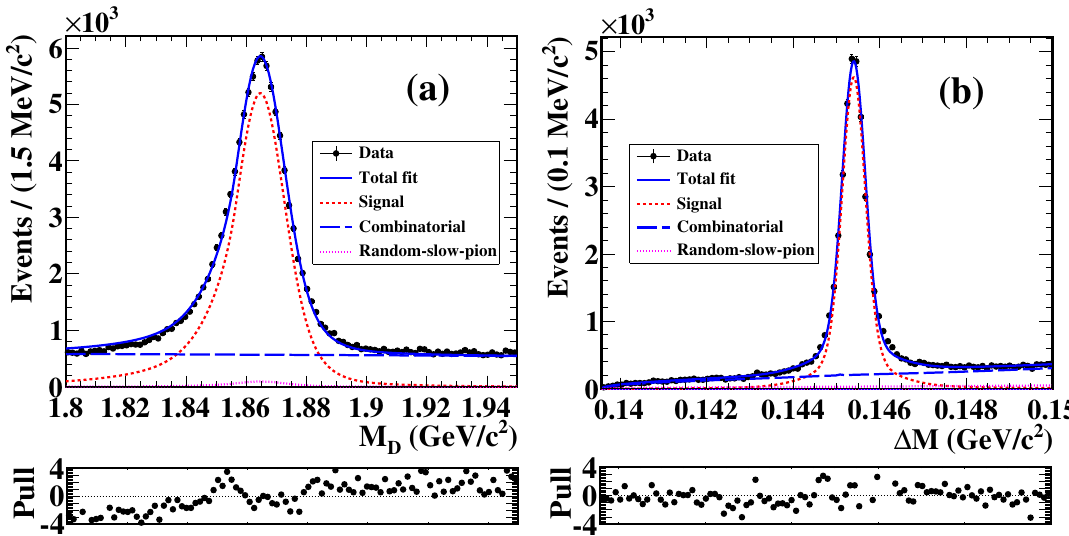
Figure 3 . Signal-enhanced (cid:12)t projections of (a) M D and (b) (cid:1) M distributions from D (cid:3)(cid:6) ! D(cid:25) (cid:6) data sample in bin 1. The black points with error bars are the data and the solid blue curves show the total (cid:12)t. The error bars are barely visible as they are smaller than the size of the points. The dotted red, blue and magenta curves represent the signal, combinatorial and random-slow-pion backgrounds, respectively. The pull between the (cid:12)t and the data is shown below the distributions.